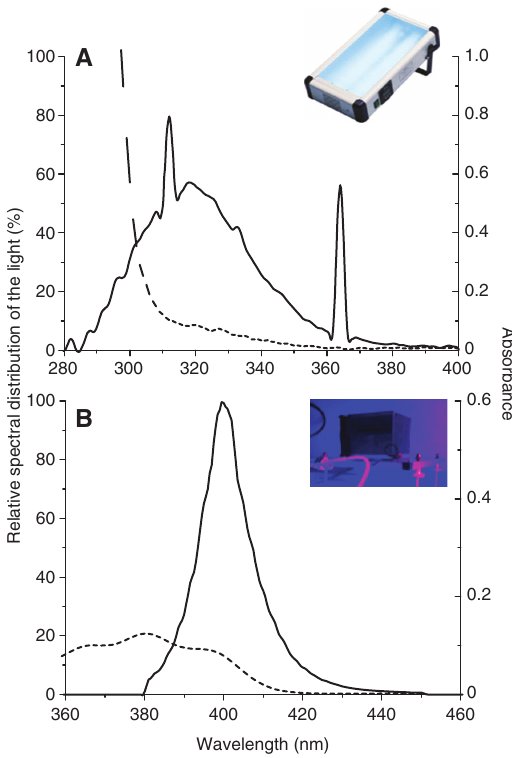
Figure 2 Emission spectra (solid line) of the two energy-saving light sources. (A) fluorescent UV lamps and (B) LED UV lamps. On the same plot, the absorption spectrum (dotted line) of the corresponding pho- toinitiator is